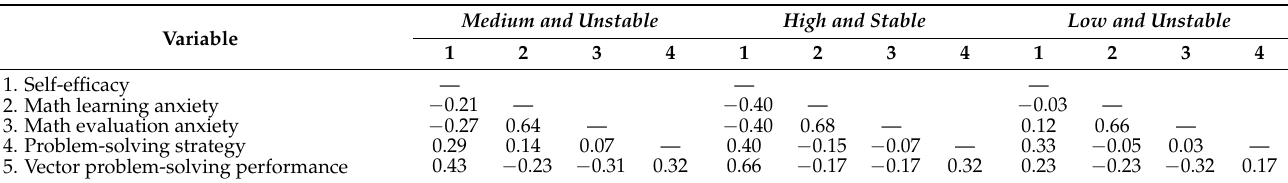
Table 8. Correlation matrixes between different clusters.